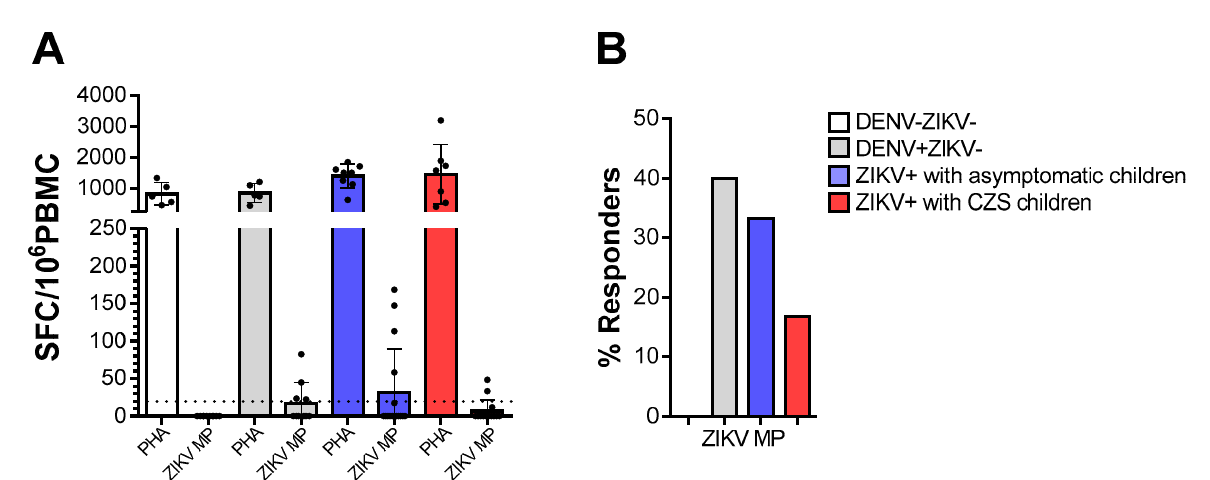
Figure 1. Ex vivo reactivity to Zika virus (ZIKV) peptides in ZIKV and/or dengue virus (DENV)-immune donors. The cell response was measured through IFN- γ production in ex vivo experiments using the ELISPOT as above, on cells from DENV-ZIKV- (white, n = 5), DENV+ZIKV- (gray, n = 5) and mothers who had asymptomatic children (blue, n = 9) and among whom had children with congenital Zika syndrome (CZS) (red, n = 7). ( A ) The magnitude of responses was expressed as the number of IFN- γ -secreting cells (SFC) per 10 6 peripheral blood mononuclear cell (PBMC). Data are expressed as averages ± standard deviations. The statistical analyses were performed using the Kruskal–Wallis test followed by Dunn’s multiple comparisons test in each donor group. ( B ) The responses were considered positive if the net ratio of SFC/10 6 PBMC constituted a stimulation index of ≥ 2. The statistical significance of differences in the frequency of response was determined using Fisher’s test. p values < 0.05 were considered significant.